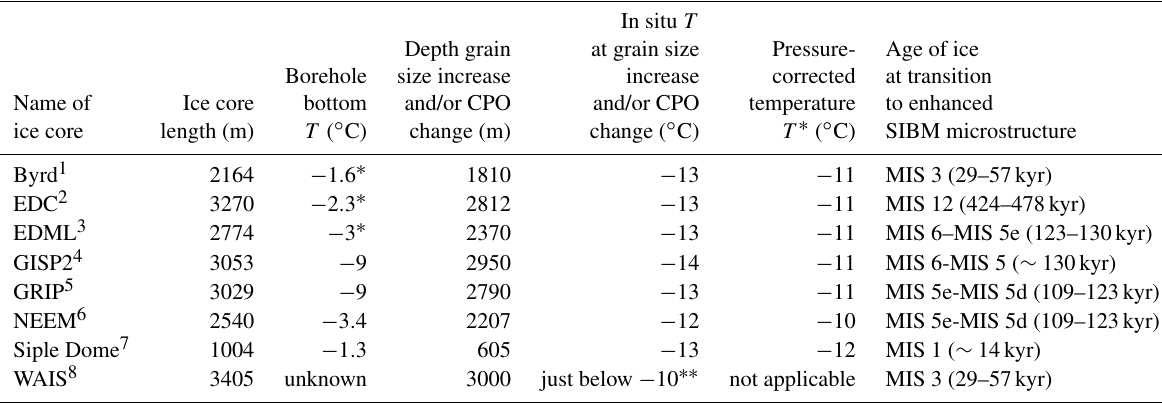
Table 1. Polar ice cores drilled at the Greenland and Antarctic ice sheets that show a sudden increase in grain size and change in CPO in the lower part of the ice core. The depth where these changes occur is given, together with ice core length, bottom borehole temperature, in situ temperature and the pressure-corrected temperature ( T ∗ ) at the sudden grain size increase and change in CPO, and the age of the ice at the transition to a sudden grain size increase and change in CPO. The age of the ice is given in marine isotope stages (MIS) and approximate ka value (Lisiecki and Raymo, 2005). In situ T Depth grain at grain size Pressure- Age of ice Borehole size increase increase corrected at